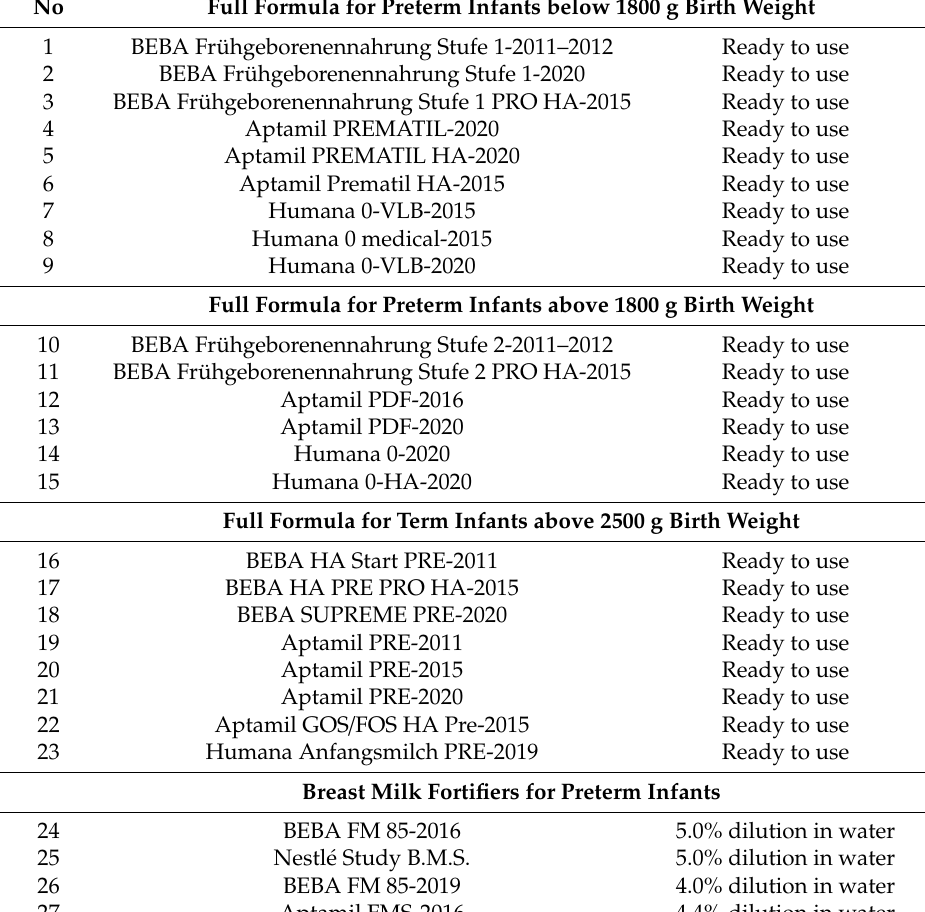
Table 1. Formulae and breast milk fortifiers for term and preterm infants. Individual compounds were stored according to the manufacturers’ instructions or frozen at − 80 ◦ C if not extracted before expiry date. Year of expiry date is indicated at the end of the product name.